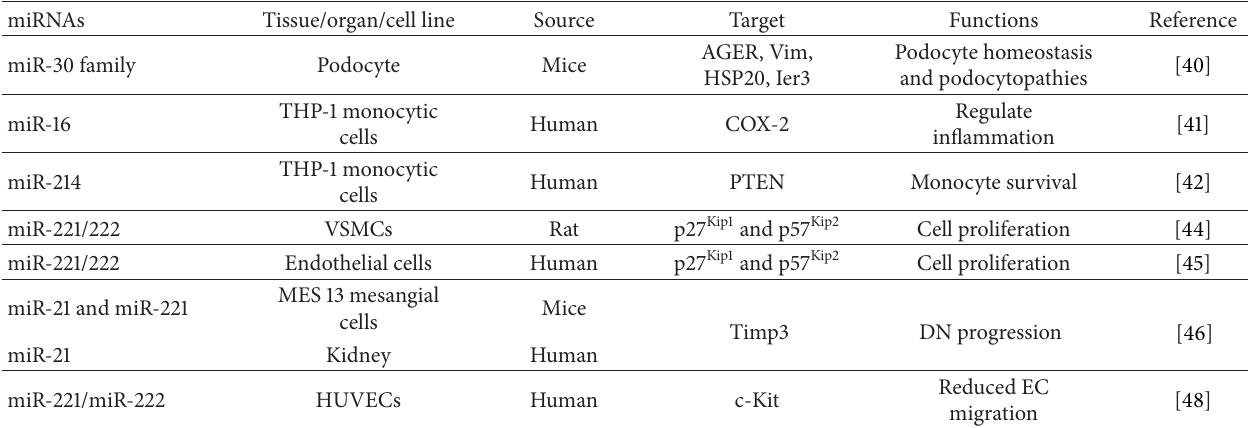
Table 2: Relevant miRNA in